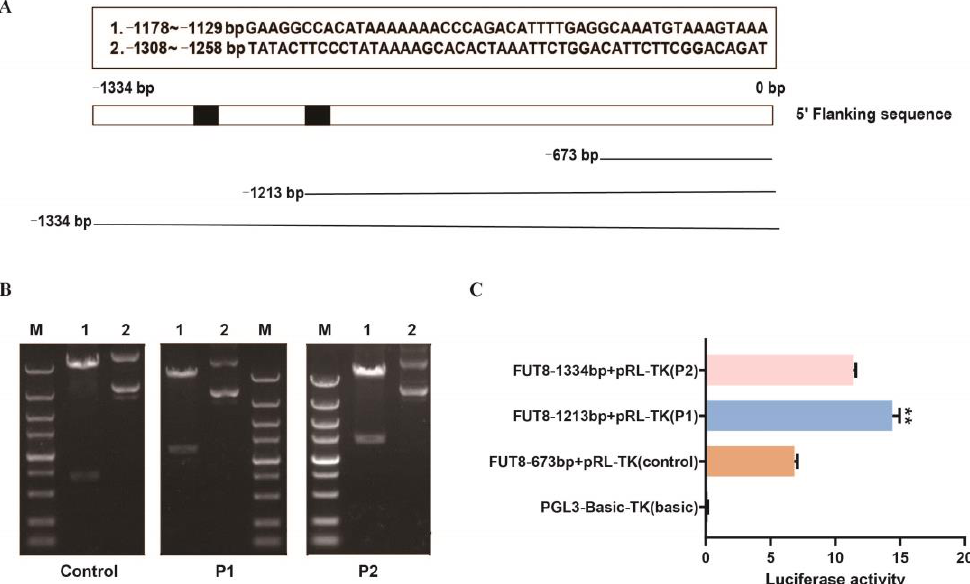
Figure 6. Impact of Pig FUT8 on the core promoter region. ( A ) Prediction of FUT8 core promoter region and truncation of detection fragment. ( B ) Agarose gel electrophoresis of PCR products that were digested by restriction enzymes. Lane 1: plasmid digested by Kpn I and Xho I; Lane 2: plasmid DNA; Lane M: DL5000 marker. ( C ) Luciferase assay of different vectors. Basic: negative control. ** p < 0.01.